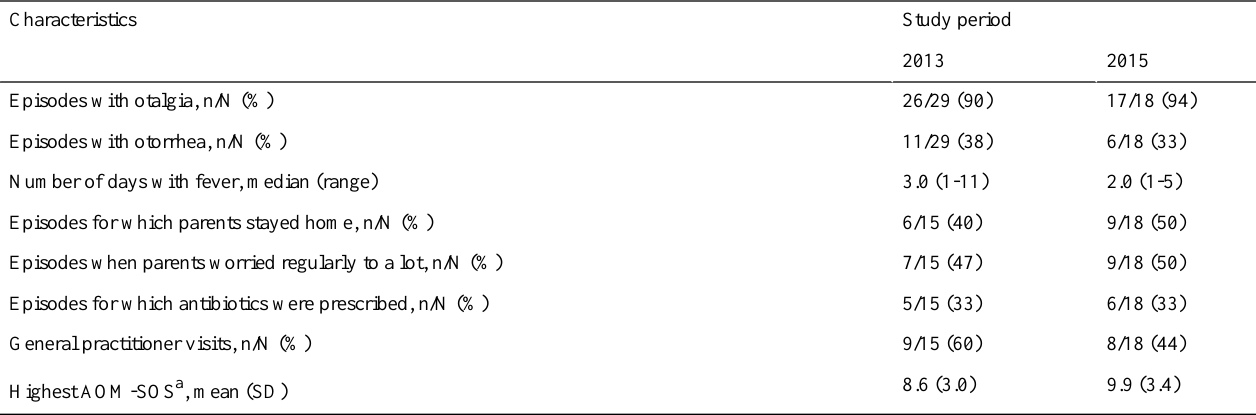
Table 3. Characteristics of parent-reported acute otitis media symptom